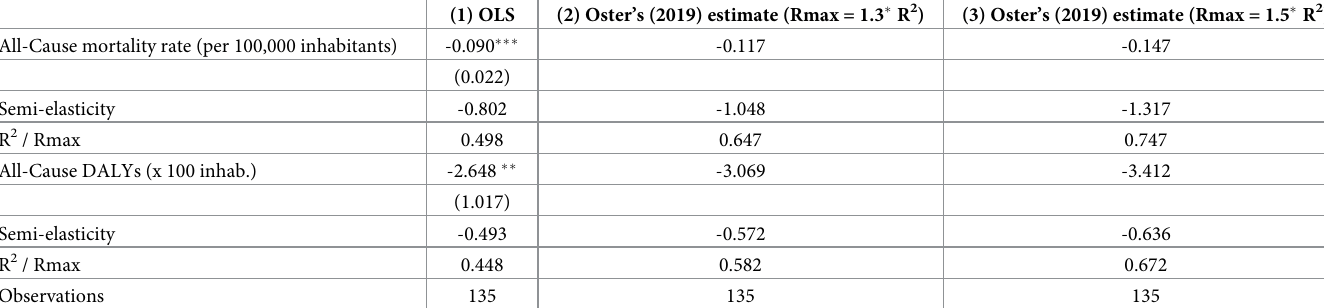
Table 2. The effect of mortality/DALYs on GDPpc growth. Long-Run Growth